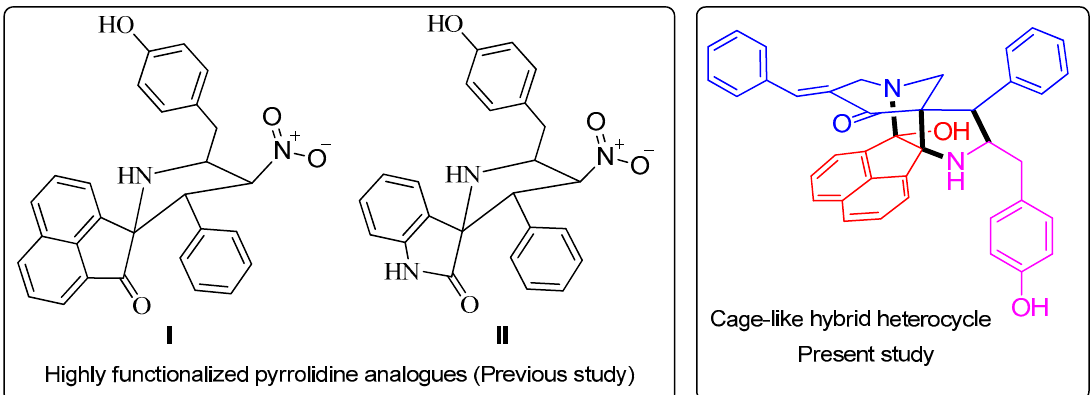
Figure 1. Schematic representation for the structural comparison of pyrrolidine analogues and cage-like hybrid heterocycles.